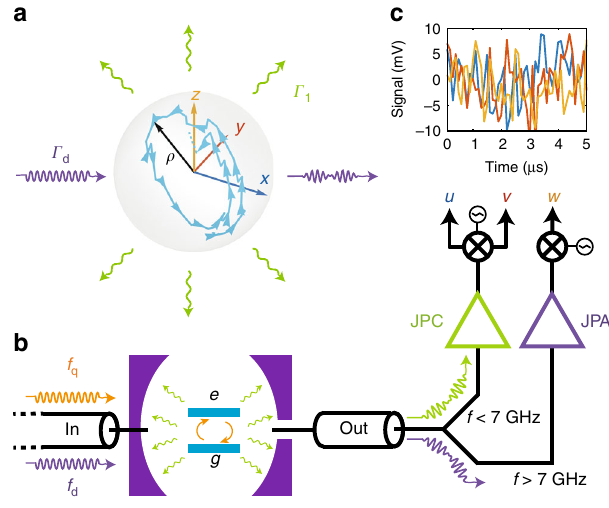
Fig. 1 Measurement setup and quantum trajectory resulting from its outputs. a Bloch vector representation of a qubit whose state is described by a density matrix ρ t = ( 1 + x ( t ) σ x + y ( t ) σ y + z ( t ) σ z )/2. A quantum trajectory ρ t is represented as a blue line. The qubit decoherence can be modeled as originating from a relaxation channel at a rate Γ 1 and a dispersive measurement channel at a rate Γ d . b A superconducting qubit in a cavity is driven by two microwave signals at the weakly coupled input. The one at qubit frequency f q = 5.353 GHz (orange) induces Rabi oscillations of the qubit at frequency Ω . The one at cavity frequency f d = 7.761 GHz (purple) leads to a dispersive measurement of the qubit state along σ z . A diplexer at the strongly coupled output port separates the outgoing signals depending on their frequency. The radiation at f q that is spontaneously emitted by the qubit is processed by a Josephson Parametric Converter (JPC) 39, 40 so that a following heterodyne measurement reveals the two quadratures u ( t ) and v ( t ) of the fl uorescence fi eld 10, 14, 41 . The transmitted signal at f d is processed by a doubly pumped Josephson Parametric Ampli fi er (JPA) 4, 42 with a pump phase such that a following homodyne measurement reveals the quadrature w ( t ) of the fi eld at f d . c Measurement records u (blue), v (red), and w (yellow) as a function of time for one realization of the experiment. These records feed the stochastic master equation, Eq. (3), which leads to the trajectory in